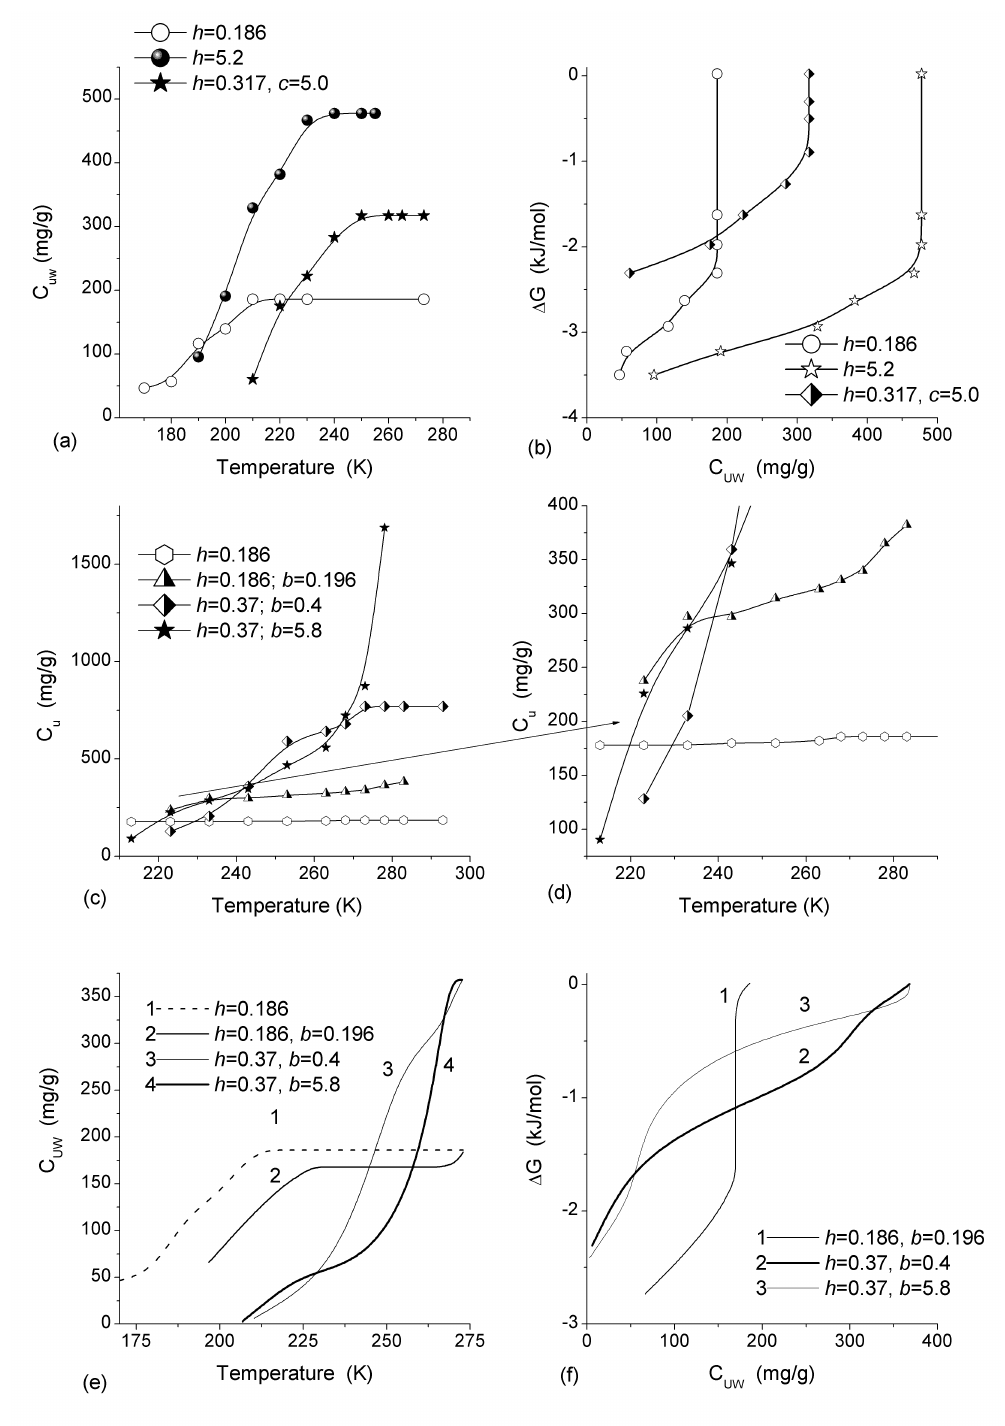
Fig. 11 Amounts of unfrozen (a, e) water and (c, d) water and benzene, and (b, f) the relationship between changes in the Gibbs free energy of adsorbed water and unfrozen water amounts on MCM-41 (sample 2); (d) shows an initial portion of the graphs shown in